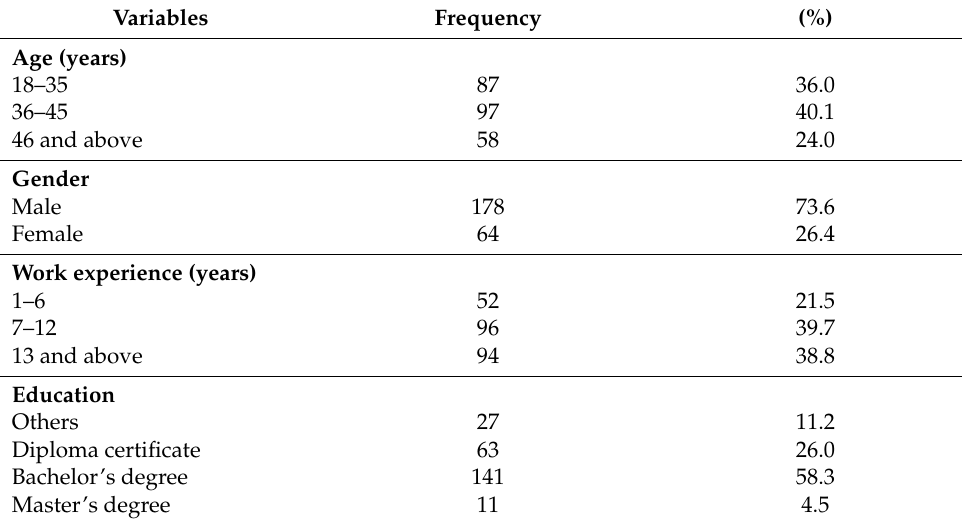
Table 1. Demographic